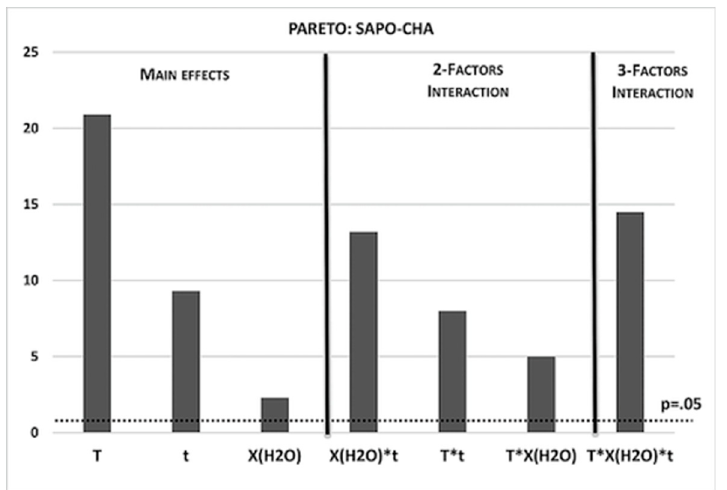
Figure 8. Pareto chart referring to the conditions used to synthesize SAPO-CHA (Reprinted from European Journal of Inorganic Chemistry, v. 2018, P. Vinaches, S. B. C. Pergher, Organic structure-directing agents in SAPO synthesis: the case of 2-ethyl-1,3,4-trimethylimidazolium, pp. 123–130, Copyright (2018), with permission from Wiley-VCH Verlag GmbH & Co.) [64].